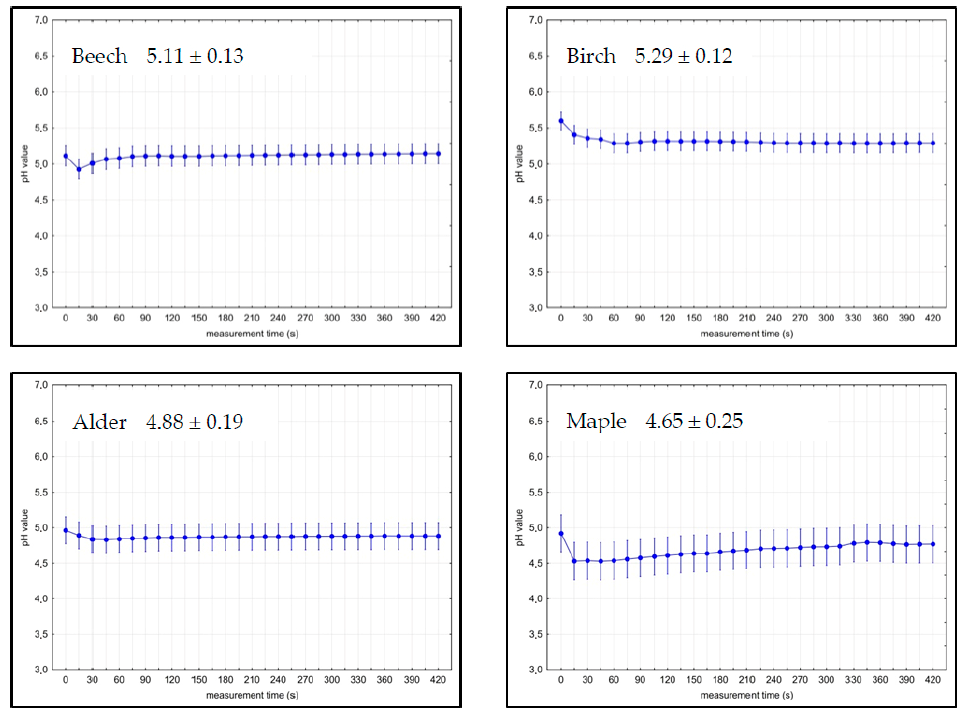
Figure 5. Graph of 95% confidence intervals of the pH value of green wood—beech, birch, alder, and maple.